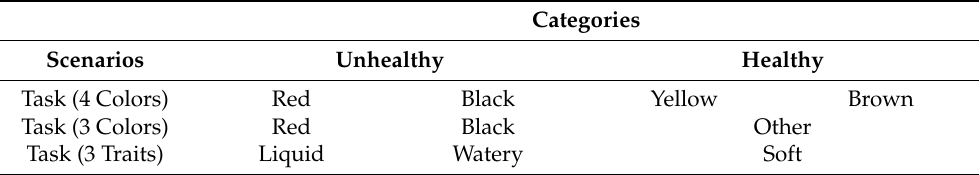
Table 1. Examination tasks.